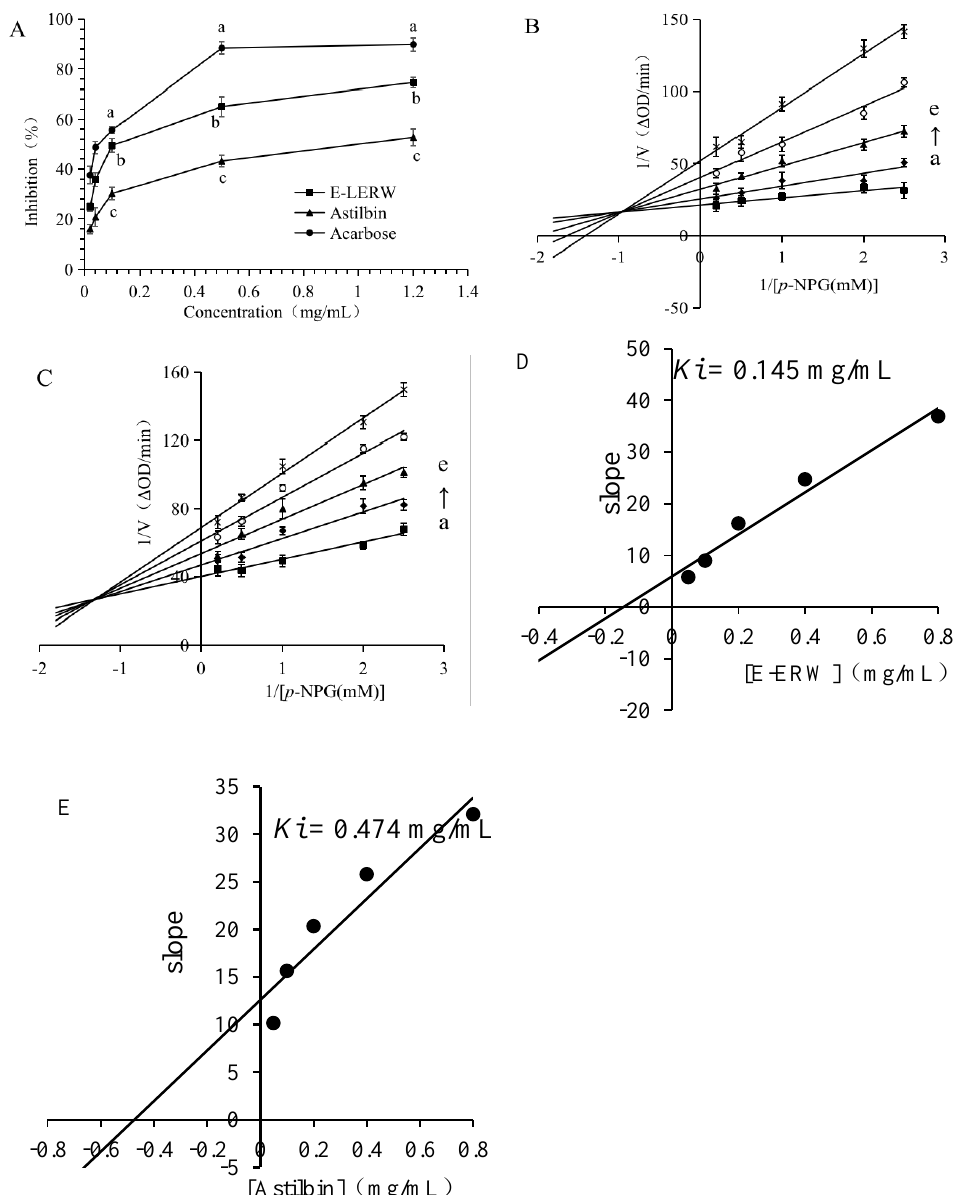
Figure 4. ( A ) The inhibitory activity of E-LERW and astilbin on α -glucosidase. ( B ) Lineweaver–Burk curve of E-LERW. ( C ) Lineweaver – Burk curve of astilbin. ( D ) The secondary plot of slope versus E-LERW concentration. ( E ) The secondary plot of slope versus astilbin concentration. A~E: 0.05, 0.1, 0.2, 0.4, 0.8 mg/mL. All values were expressed as the mean ± SD of triplicate experiments. The different letters represent significant difference at p < 0.05 by ANOVA and Duncan’s test.